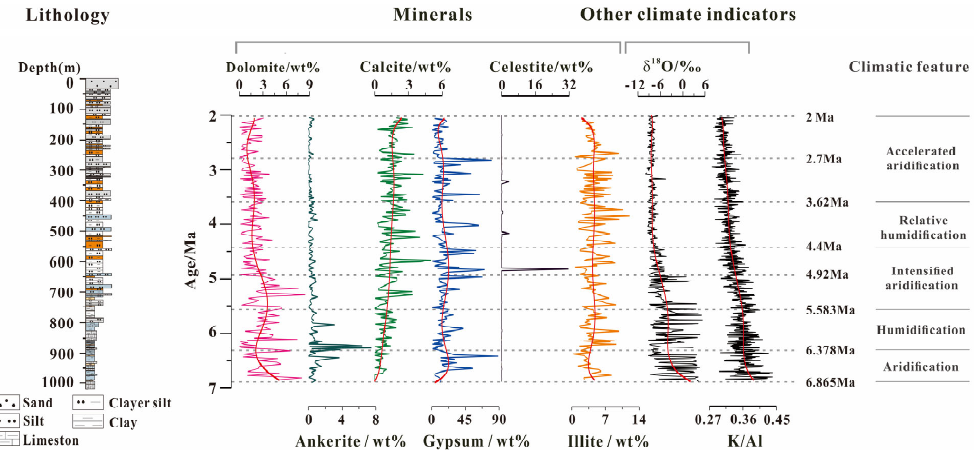
Figure 2. Lithological profiles [21], minerals (this study), δ 18 O [7] and K/Al [5] in lacustrine sediments from drill core Ls2 in the eastern Tarim Basin. Red curves represent long-term trends.